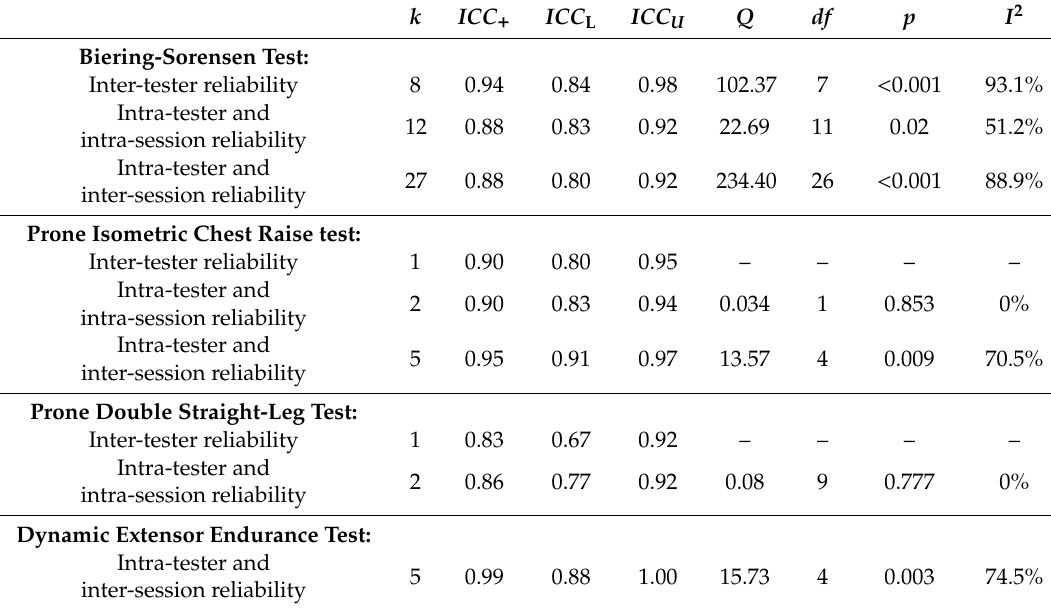
Table 2. Average reliability, 95% confidence intervals, and heterogeneity statistics for each field-based test and reliability